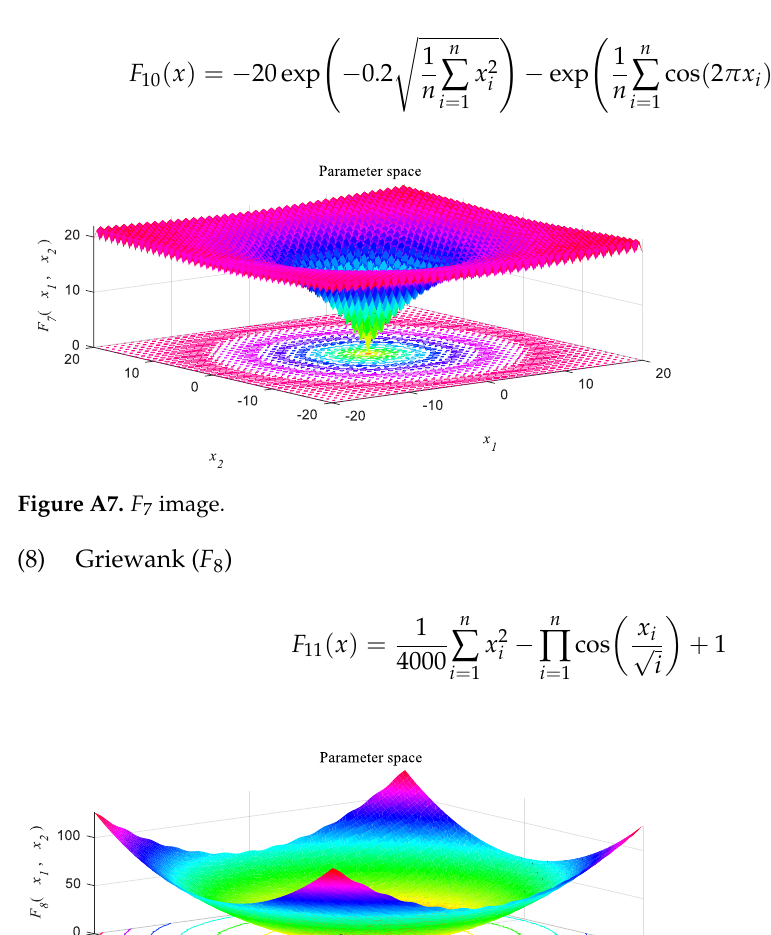
Figure A6. F 6 image.